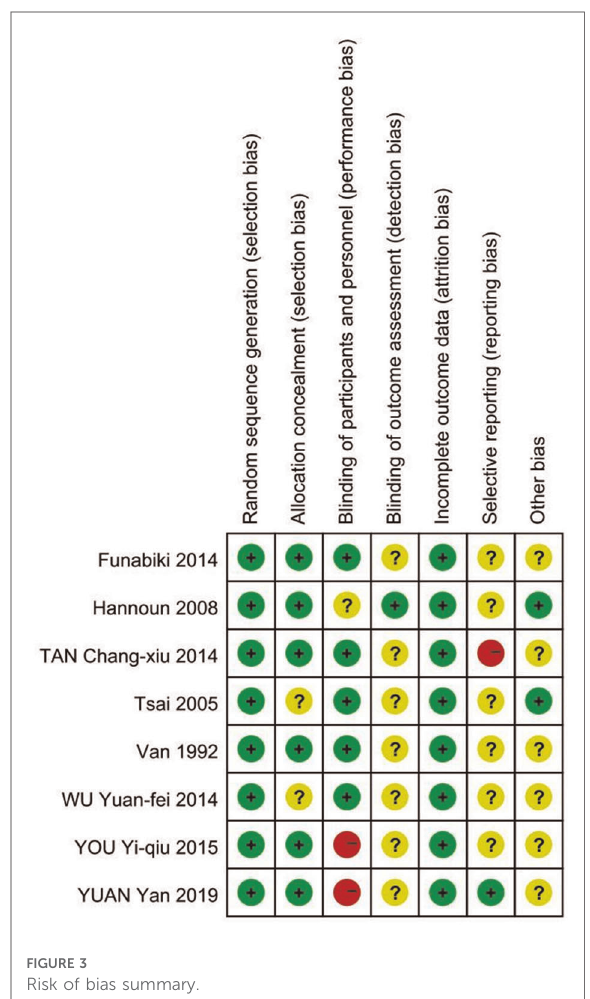
FIGURE 3 Risk of bias